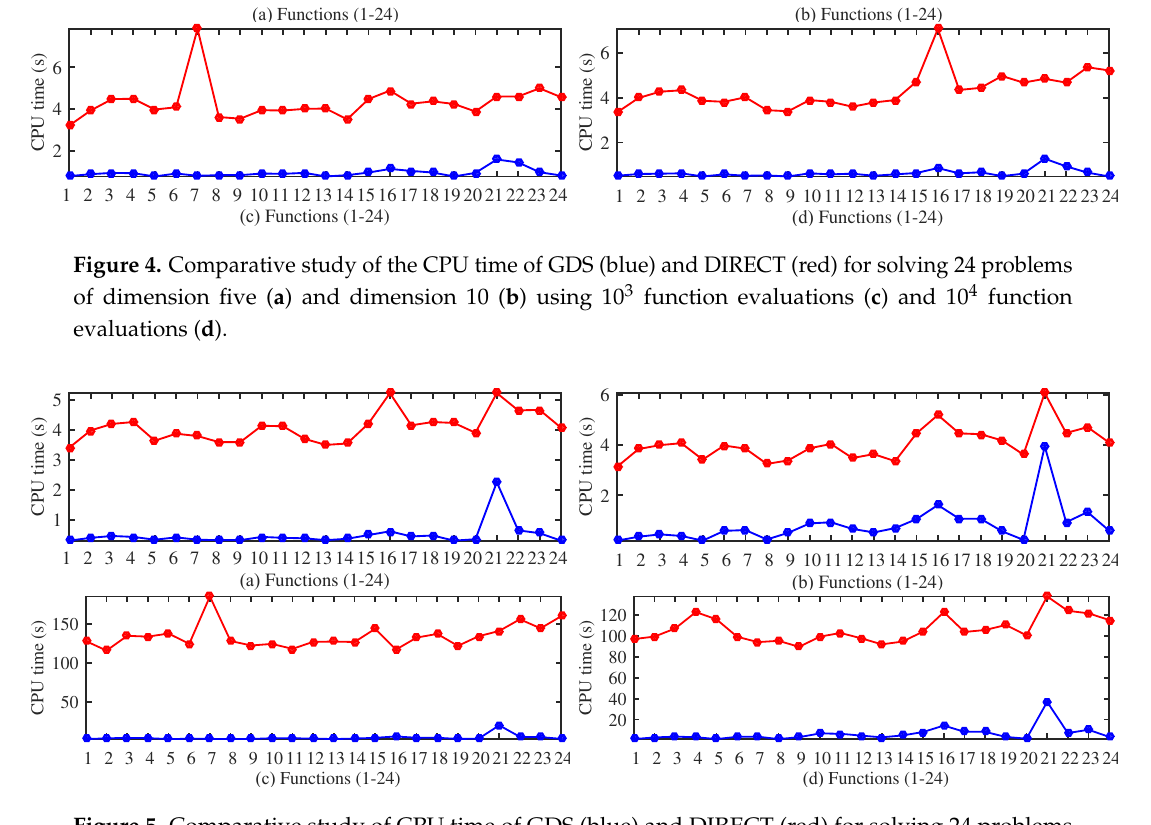
Figure 5. Comparative study of CPU time of GDS (blue) and DIRECT (red) for solving 24 problems of dimension 20 ( a ) and dimension 40 ( b ) using 10 4 function evaluations ( c ) and 10 5 function evaluations ( d ).